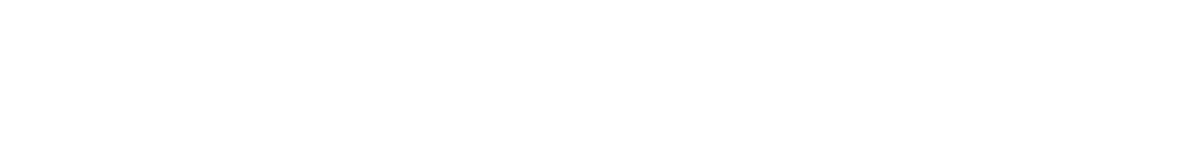
TABLE 5 | Dissipated energy, elastic strain energy, and their ratio to total energy of each characteristic stress point in the crack growth stage. Phase cutoff point σ 3 (MPa) Initiation point